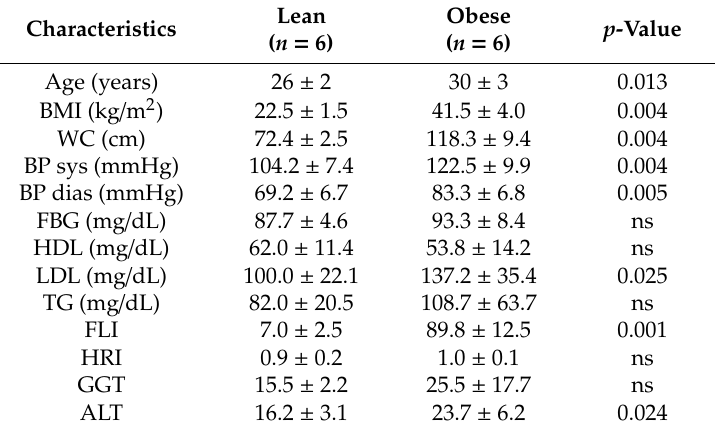
Table 1. Baseline characteristics of the study